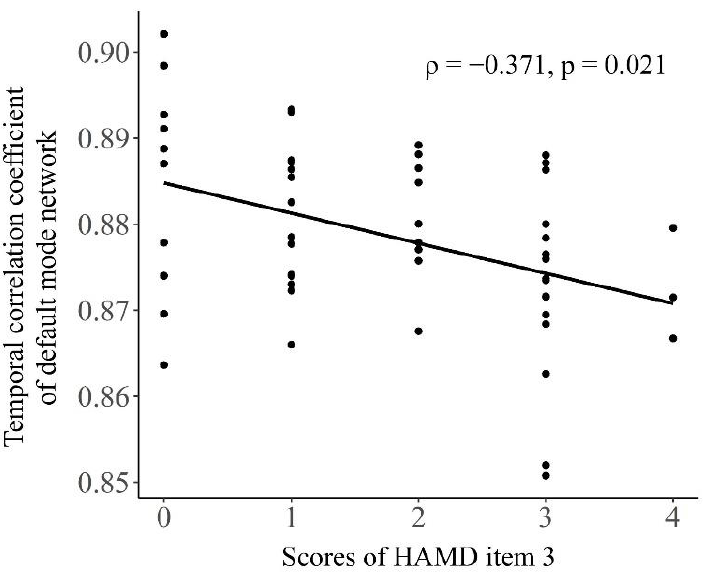
Figure 4. The relationship between the temporal correlation coefficient of default mode network and the scores of HAMD item 3 in the patients with major depressive disorder. The Spearman’s correlation coefficient ( ρ ) and FDR-corrected p value were presented on the figure.